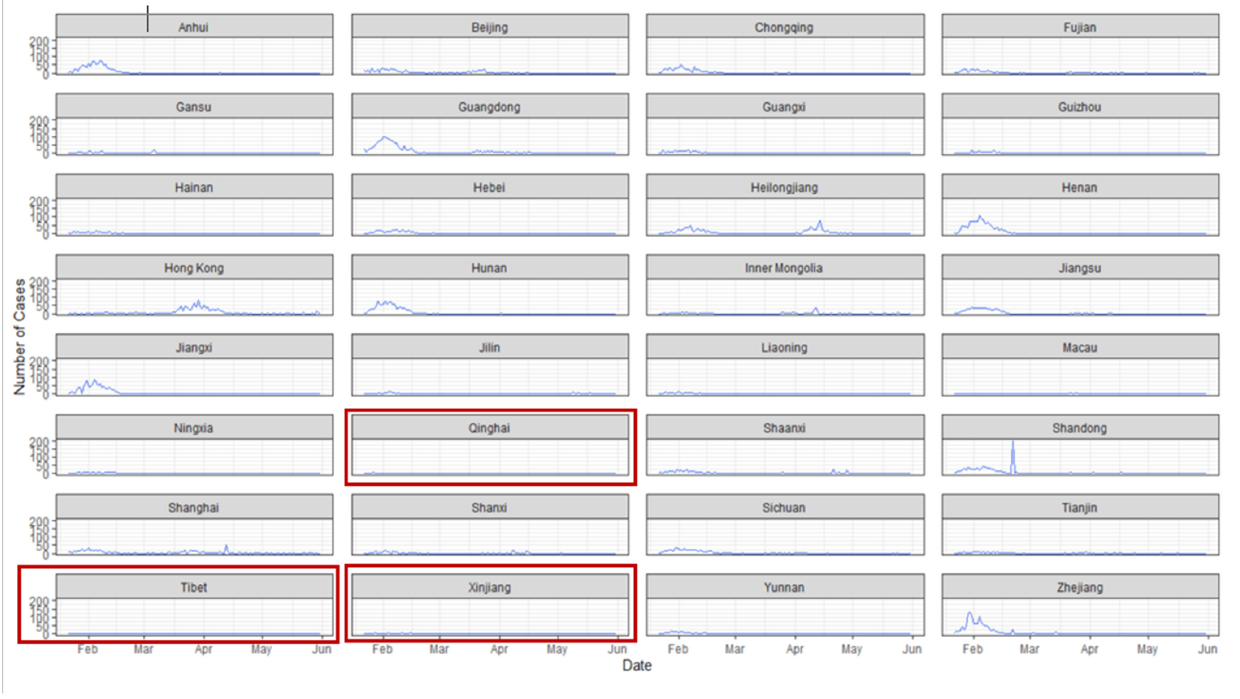
Figure 1. Spatiotemporal plot of COVID ‐ 19 cases in China. Table 1 shows the spatial averages of each region in ascending order. Accordingly, three of the areas which are not included in the cluster have the lowest spatial averages. Table 1. Spatial averages of COVID ‐ 19 cases.